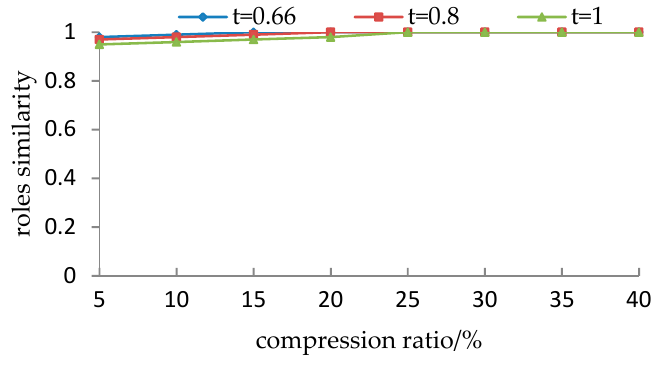
Figure 1. Comparison of sim P ( PA compressed , PA initial ).